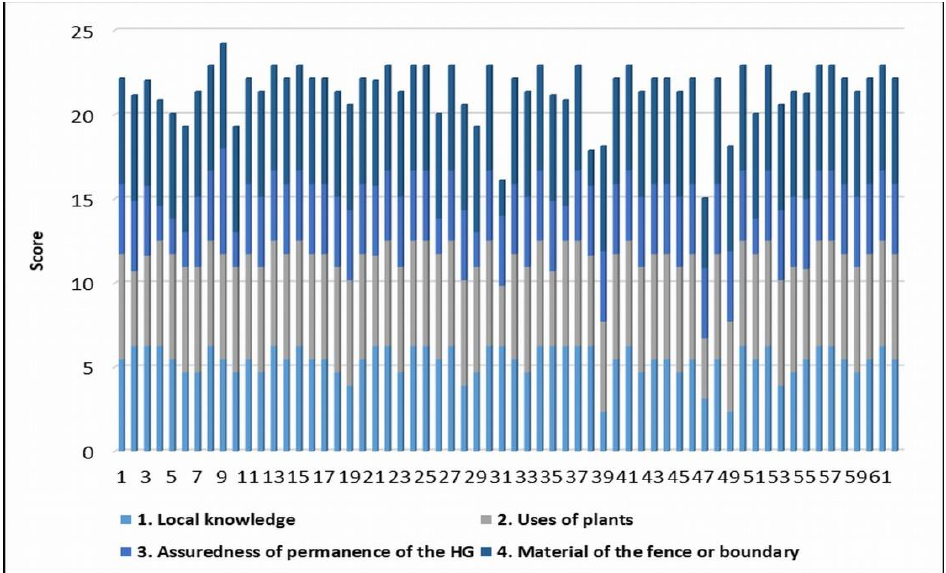
Figure 4. Accumulated value per home garden for the integration